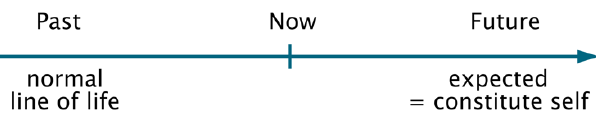
Figure 1. Normal line of line that helps to constitute the self.